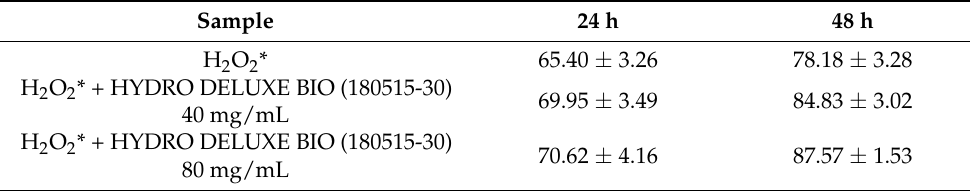
Figure 3. Protective effect of the product HYDRO DELUXE BIO against H 2 O 2 -induced oxidative damage. HaCaT cells were co-treated with 40 and 80 mg/mL and H 2 O 2 used as oxidative stress. 24 h: treatment with the tested product + H 2 O 2 0.125 mM; 48 h: treatment with the tested product + H 2 O 2 0.0625 mM. * p ≤ 0.05 ** p ≤ 0.01 were considered, respectively, to be statistically significant when compared with H 2 O 2 by one-way ANOVA statistical analysis. Table 3. Percentage changes (mean ± SD) in cell viability after 24 and 48 h of treatment with the oxidative stressor and the product HYDRO DELUXE BIO at the two non-cytotoxic concentrations of 40 and 80 mg/mL. *H 2 O 2 was used at two different concentrations, 0.125 mM for 24 h treatment and 0.0625 mM for 48 h treatment.